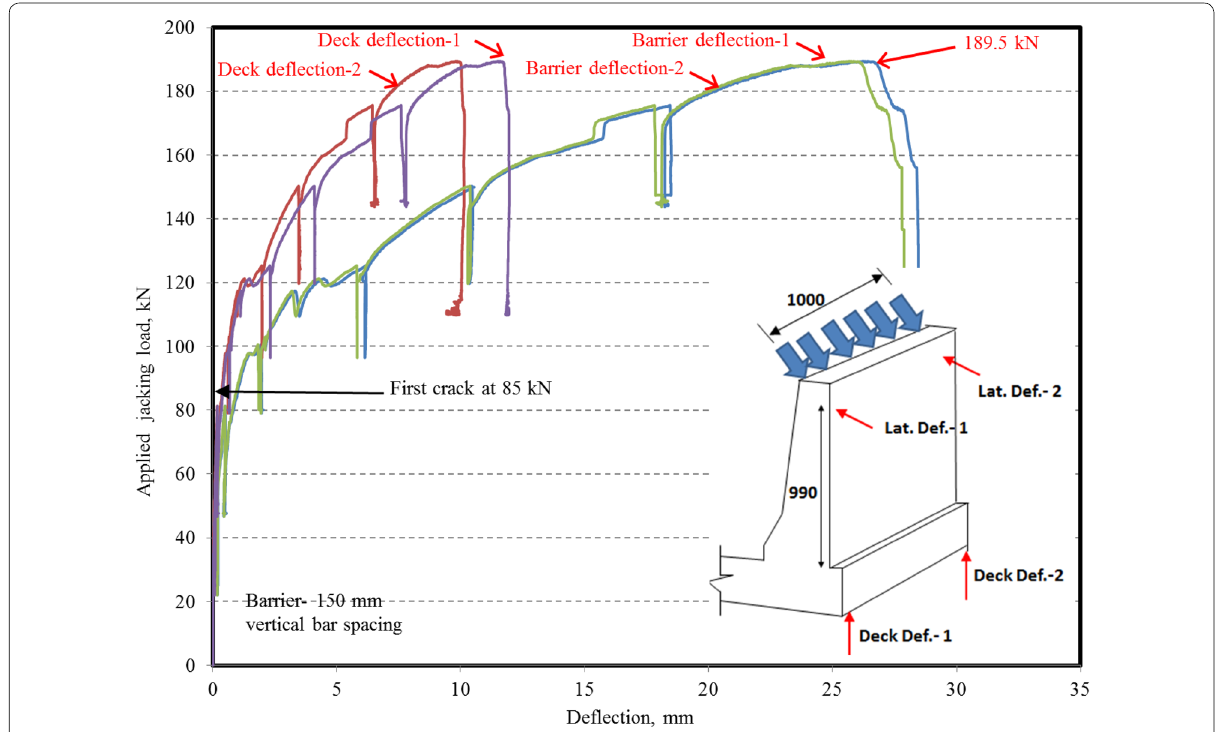
Fig. 19 Load-deflection relationship of the 1-m barrier wall at exterior